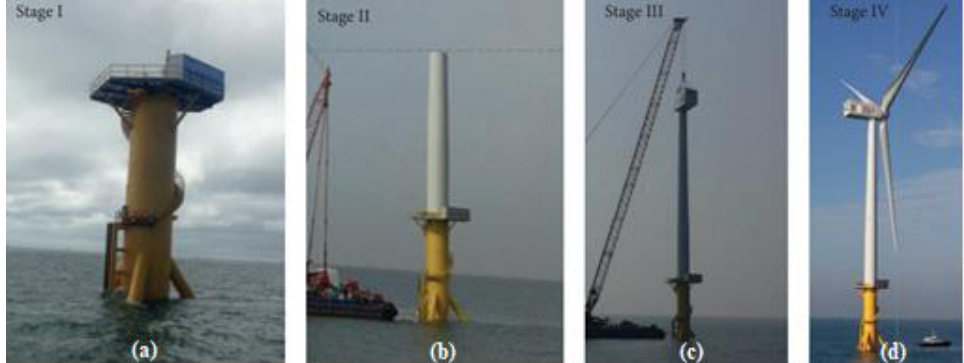
Figure 4. Measurement framework consisting of four stages during construction: ( a ) stage I, ( b ) stage II, ( c ) stage III, and ( d ) stage IV.